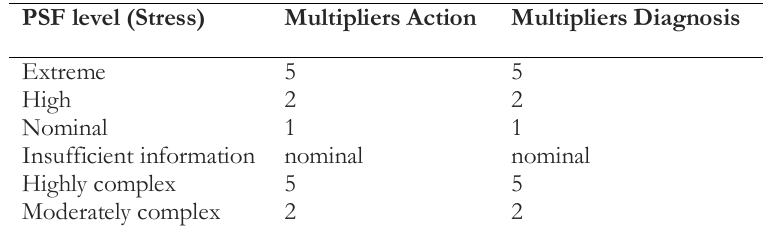
Table 2. The value of PSF level (Stress).